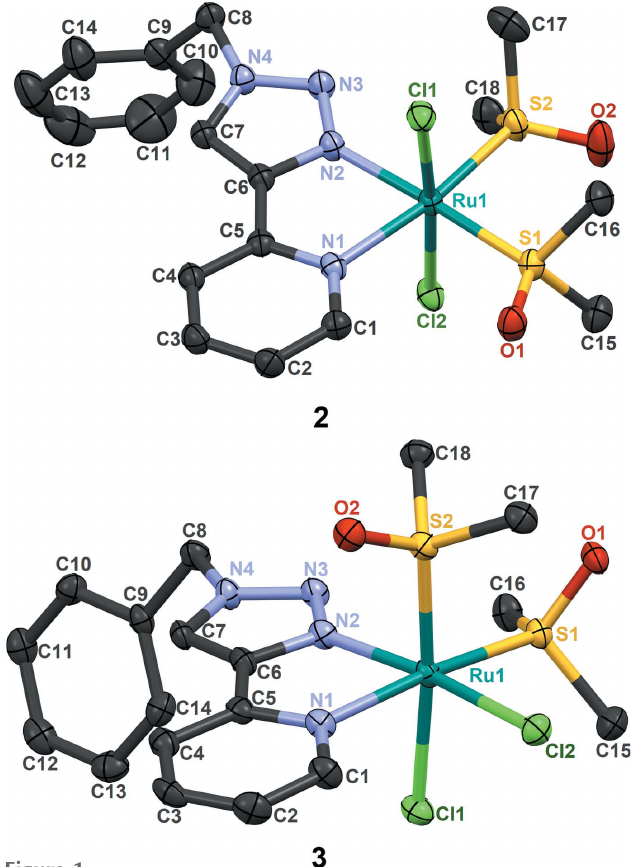
Figure 1 X-ray structures of 2 and 3. Displacement ellipsoids are drawn at the 50% probability level, and hydrogen atoms are omitted for clarity.